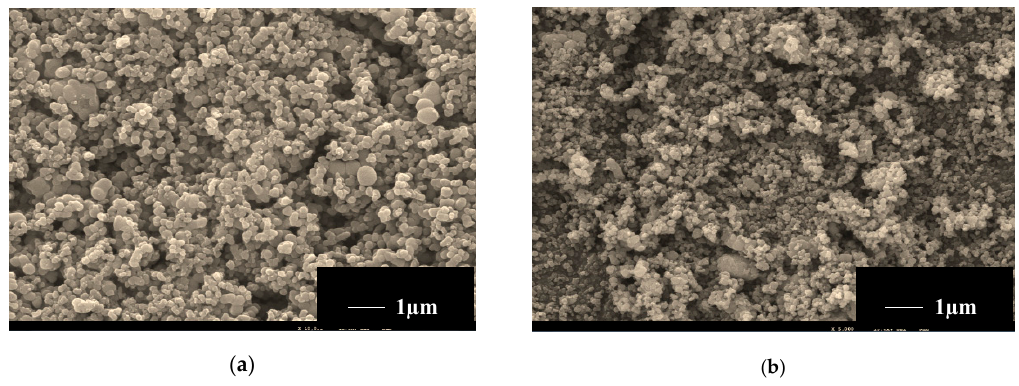
Figure 5. SEM images of: ( a ) Fe 3 O 4 /TiO 2 ; ( b ) Fe 3 O 4 /TiO 2 /[FeCl 2 { κ 3 - HC(pz) 3 }].